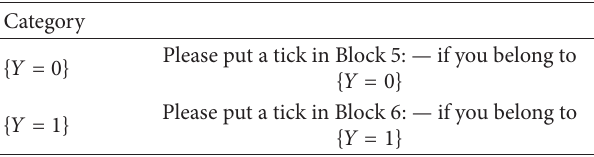
Table 2: The supplemental questionnaire for the combination questionnaire